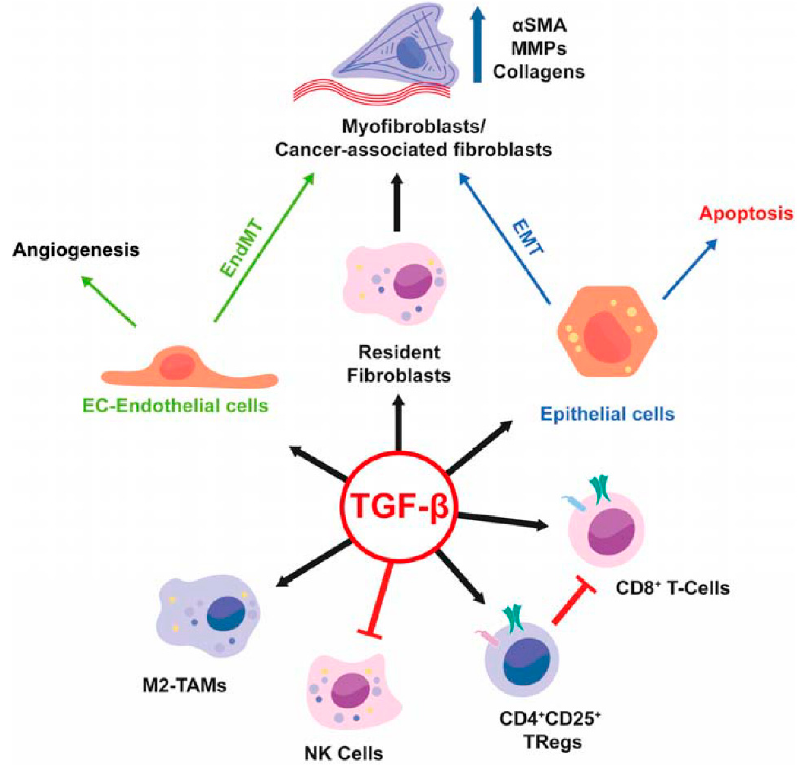
Figure 2. Role of TGF- β in the tumor microenvironment (Under Creative Commons Attribution (CC BY) license from: Caja et al. [7]).